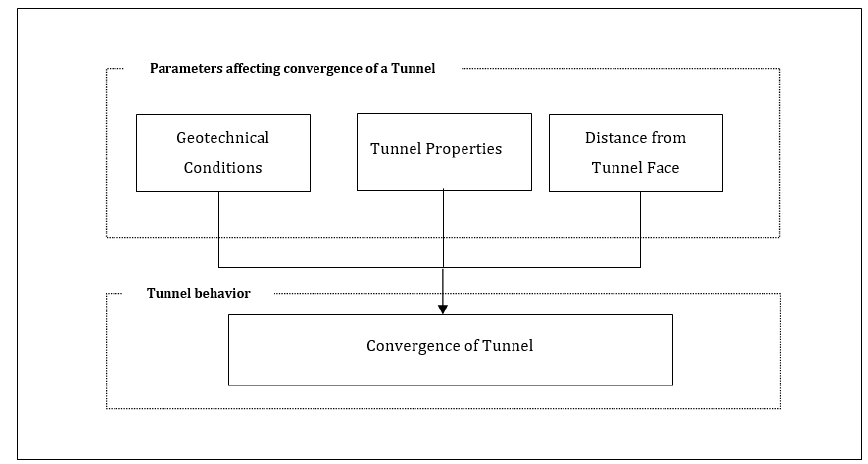
Figure 5. Influential parameters causing tunnel convergence.